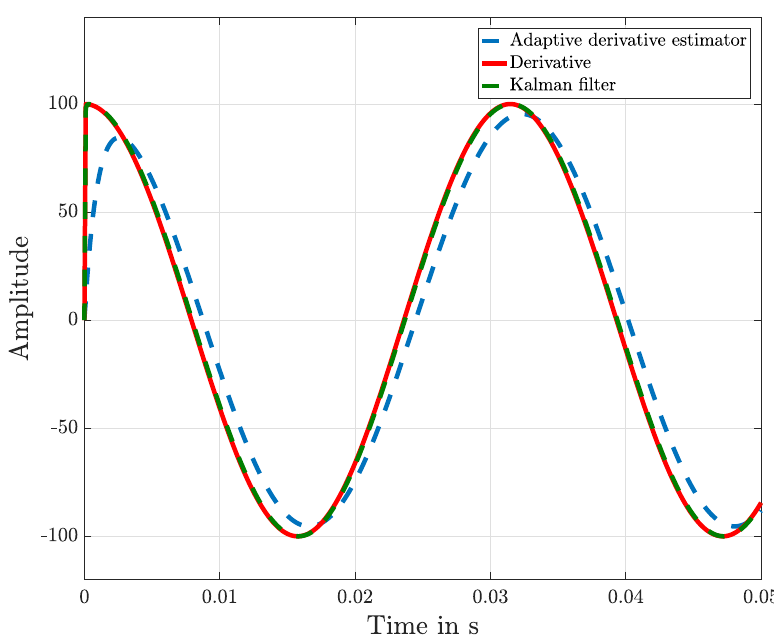
Figure 2. Graphical representation of the position y ( t ) .